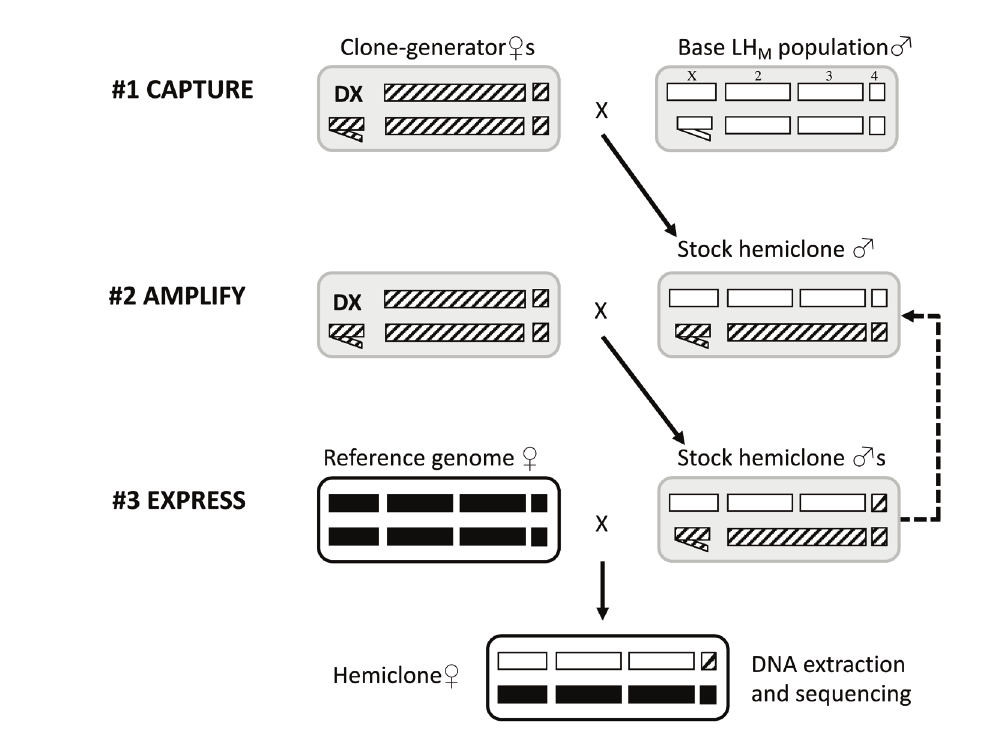
Figure 1. Breeding design for generating each hemiclonal line. 1 Capture - Single wild-type male from the base-population (open chromosomes) was crossed to five clone generator female, which harbour a fused double-X chromosome (DX), a Y chromosome, as well as a marked translocation of chromosomes 2 and 3 (hatched chromosomes; see text for full genotype). This cross captured a single wild-type haplotype. 2 . Amplify - A single heterozygous male was then crossed again to a group of clone-generator females to amplify the number stock hemiclonal males. This cross can be repeated, to replenish the stock hemiclone males. 3 Express - Finally, a single reference genome female (filled chromosomes) was crossed to a single stock hemiclonal male to produce a female that harbours the original wild-type haplotype (excluding the 4th dot chromosome, which remains uncontrolled throughout), in a reference genome genetic background. Cytoplasmic factors in the offspring also derive from the reference genome stock (black outline). DNA is extracted from a single hemiclone female from each line and